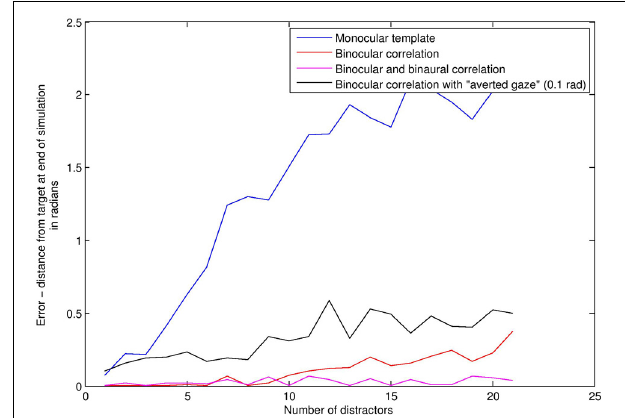
FIGURE 6 | Face detection error rates (vertical axis) under increasing levels of distractors (horizontal